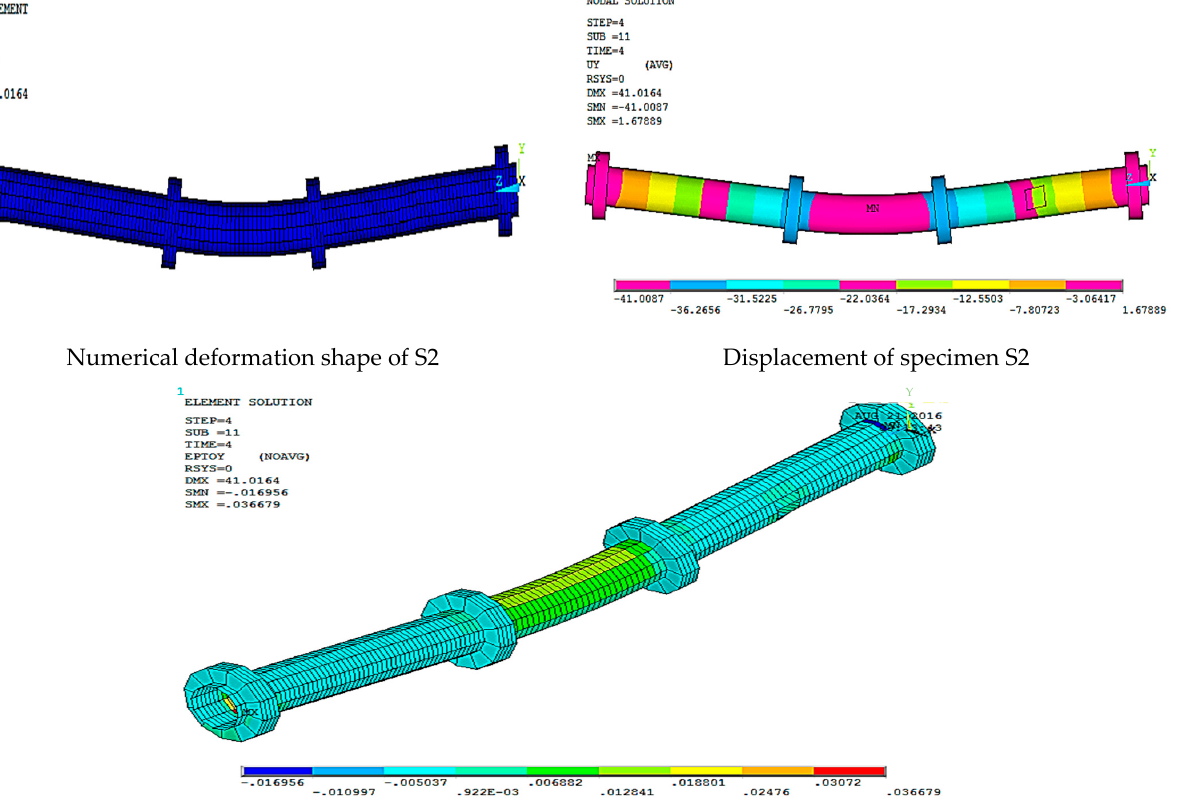
Figure 17. Numerical analysis of S2.